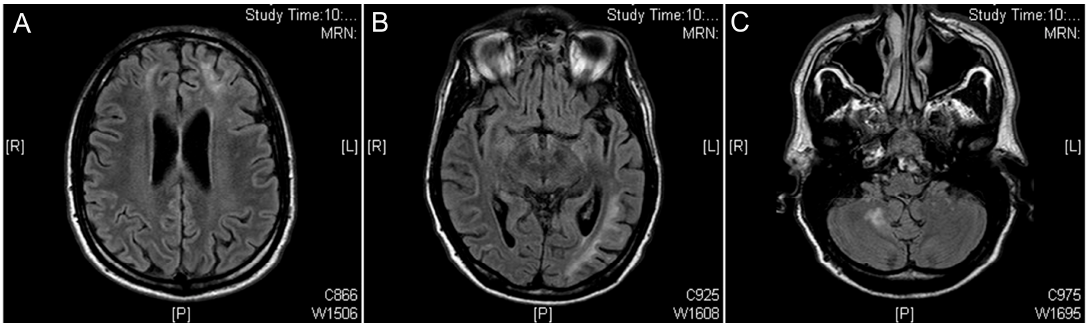
Figure 4. Case 1, Neurosyphilis. Magnetic resonance imaging (MRI) of the brain with gadolinium showing the presence of multiple hyperintense lesions in long repetition time (TR) sequences localized bilaterally in frontal hemispheres ( A ); in temporal, parietal and occipital left hemispheres ( B ) and in the right cerebellum peduncle ( C ). MRN: magnetic resonance neurography; R: right; L: left; P: posterior.